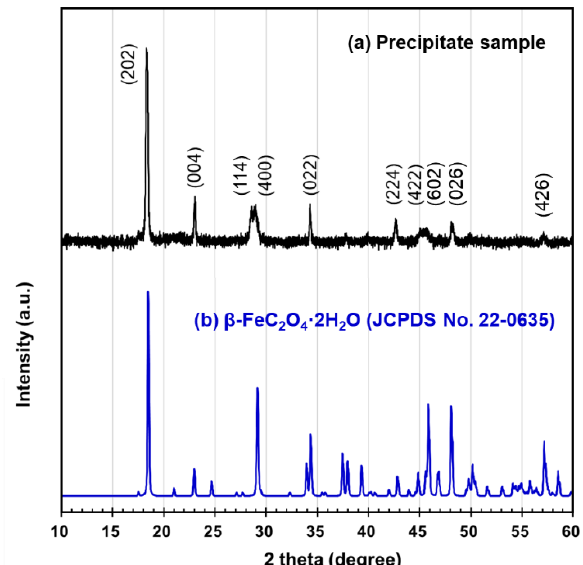
Figure 5. XRD patterns of ( a ) the precipitate sample obtained in this work, ( b ) standard β - FeC 2 O 4 ·2H 2 O (JCPDS No. 22-0635).